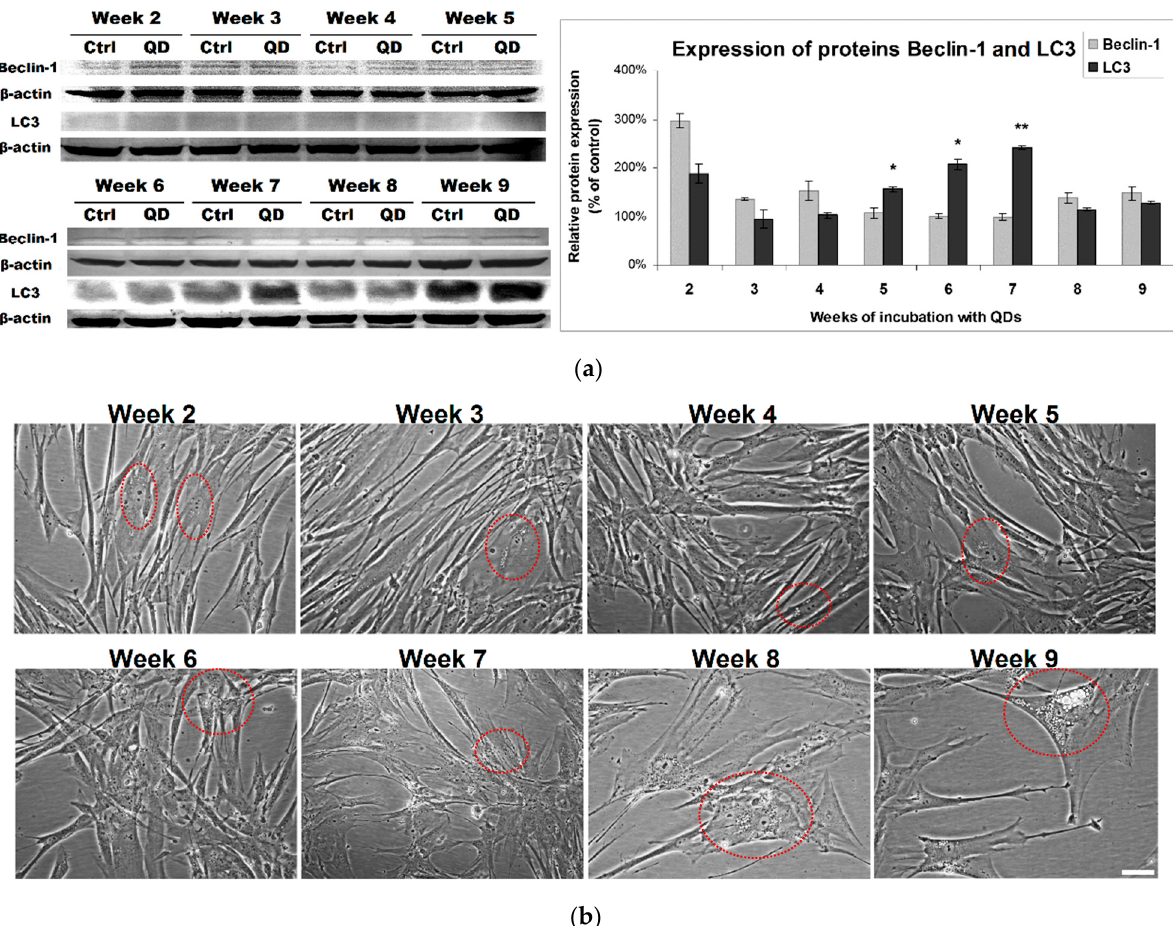
Figure 5. Effect of long-term exposure to Si/SiO 2 QDs on the activation of autophagy pathway in MRC-5 cells. ( a ) Expression levels of Beclin-1 and LC3 proteins during the 9 weeks of incubation with Si/SiO 2 QDs were calculated as mean ± SD ( n = 3) and represented relative to control (* p < 0.05 and ** p < 0.01 compared to control). ( b ) Morphology of MRC-5 lung fibroblasts and progressive formation of autophagic vacuoles (red dot circles) were evidenced by phase-contrast optical microscopy during the 9 weeks of incubation with Si/SiO 2 QDs. Scale bar of 50 µm is the same for all images.